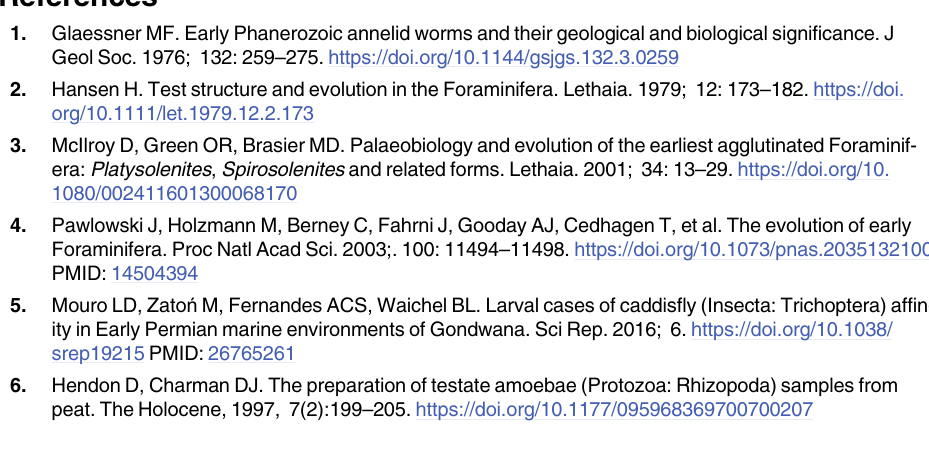
(ZIP) S3 Fig. BSE image of aggregated tubes (the same of Fig 1; photo 2) that has been vertically sectioned (section 6A). The coloured crosses indicate the spots for standardless microanaly- ses; the corresponding EDS spectra as well as the elemental maps are reported below. (TIF) S4 Fig. 1) SEM image in secondary electrons of Sabellaria alveolata bioconstruction from site SB (horizontal view showing the typical honeycomb structure). 2–5) BSE images of aggregated tubes (the same of photo 1) that have been vertically sectioned (sections 1A and 1B). The elemental maps are reported below. Noteworthy is the disposition and composition of the agglutinated grains that does not changed in the bioconstructions from the two studied sites. S5 Fig. BSE images of aggregated tubes from Santa Barbara site that has been vertically sectioned (sections 2A and 2B). The elemental maps are reported